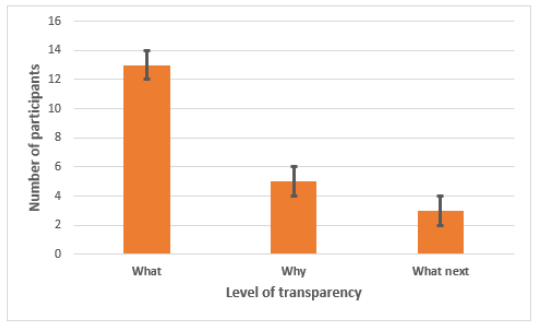
Figure 4: User preference regarding level of transparency.